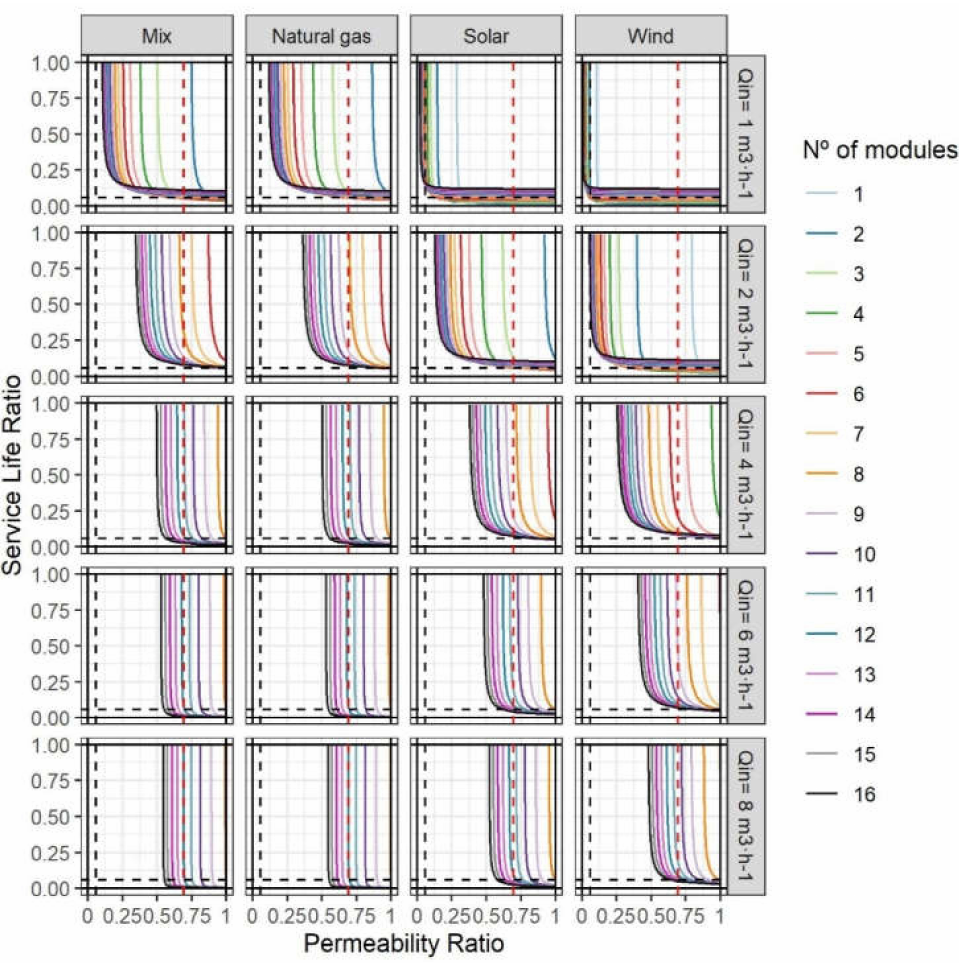
Figure 5. Results of the hybrid analytical–numeric method for r-NF with Strategy B (n c (cid:54) = n r ). Reference scenario for NF-270: SL = 10 years, n c = 8 and WR = 0.5. The number of modules refers to n r . The dashed red line illustrates LR in the case study (0.69) and the dashed black lines the ratio of the replacement impact (0.0579).One difference compared with strategy A is the limitation in the minimum SLR, which varied depending on the contribution of the replacement. With low flows and with non-fossil-based energy sources, the minimum SLR depended on n . However, with a highly energy-dependent scenario, that SLR could be compensated for up to almost 0 by a lower SEC